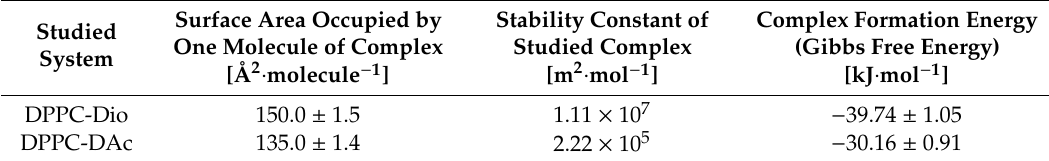
Table 2. Some physicochemical values for the obtained